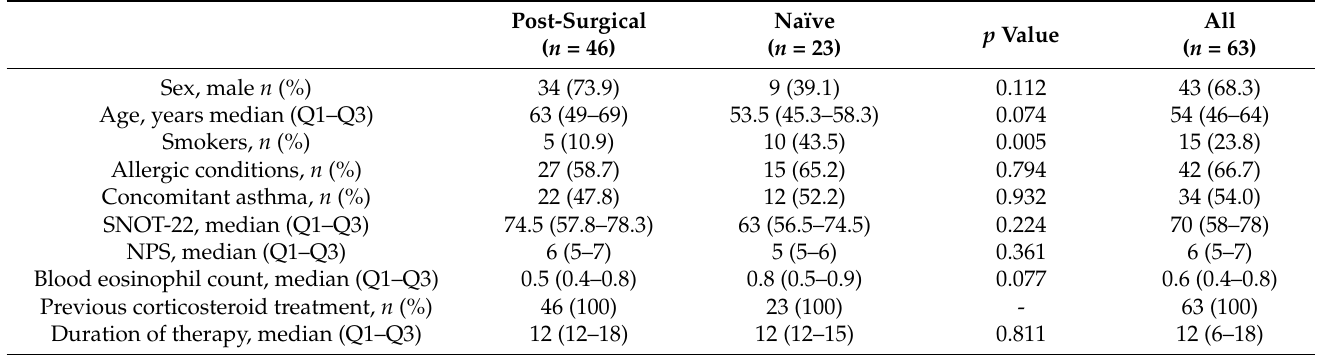
Table 1. Patients’ main clinical characteristics and endoscopic and symptom evaluations at baseline for the whole group and for the post-surgical and naïve groups separately.